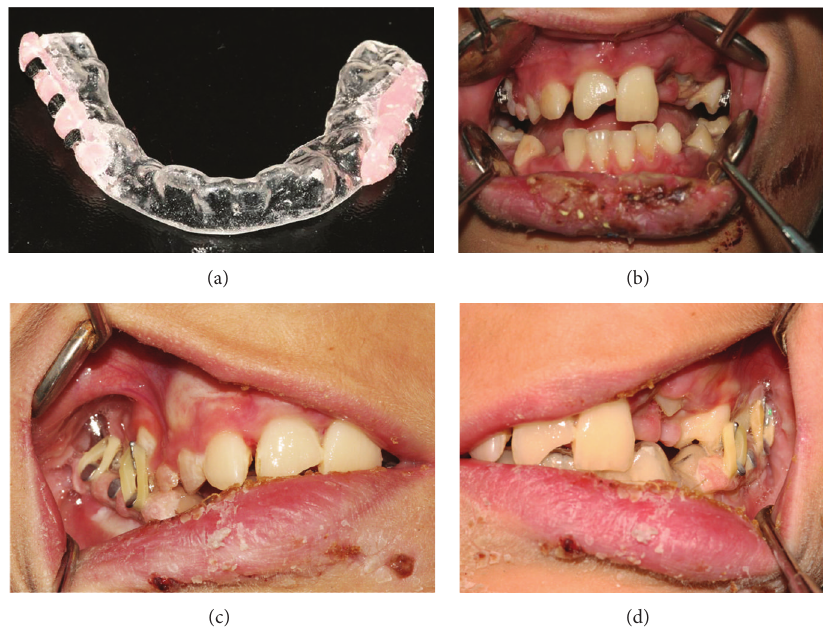
Figure6:(a)Vacuumformedsplintusedforfunctionalrepositioning.(b)Intraoralphotographshowingthebracketsattachedtothemaxillary posterior teeth. (c-d) Orthodontic elastics guide the patient into centric occlusion.